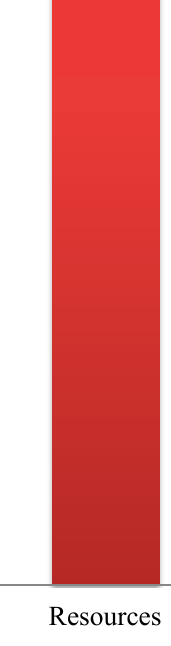
Figure 7. Single scores of damage categories in the olive kernel oil production chain (unit = μ Pt).